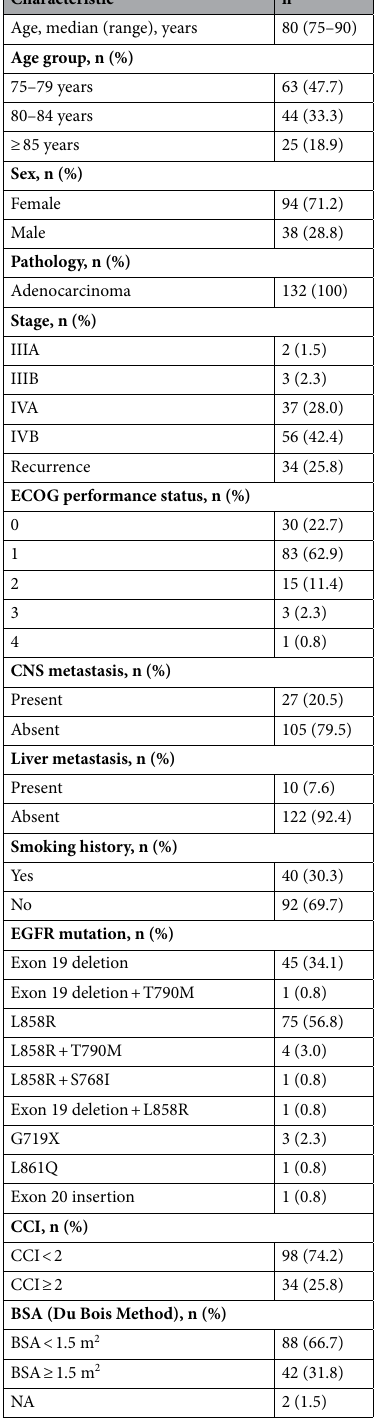
Table 1. Baseline characteristics of patients aged 75 years or older with NSCLC who were treated with osimertinib as first-line therapy (n = 132). BSA body surface area, CCI Charlson comorbidity index, CNS central nervous system, ECOG Eastern Cooperative Oncology Group, EGFR epidermal growth factor receptor, NA not